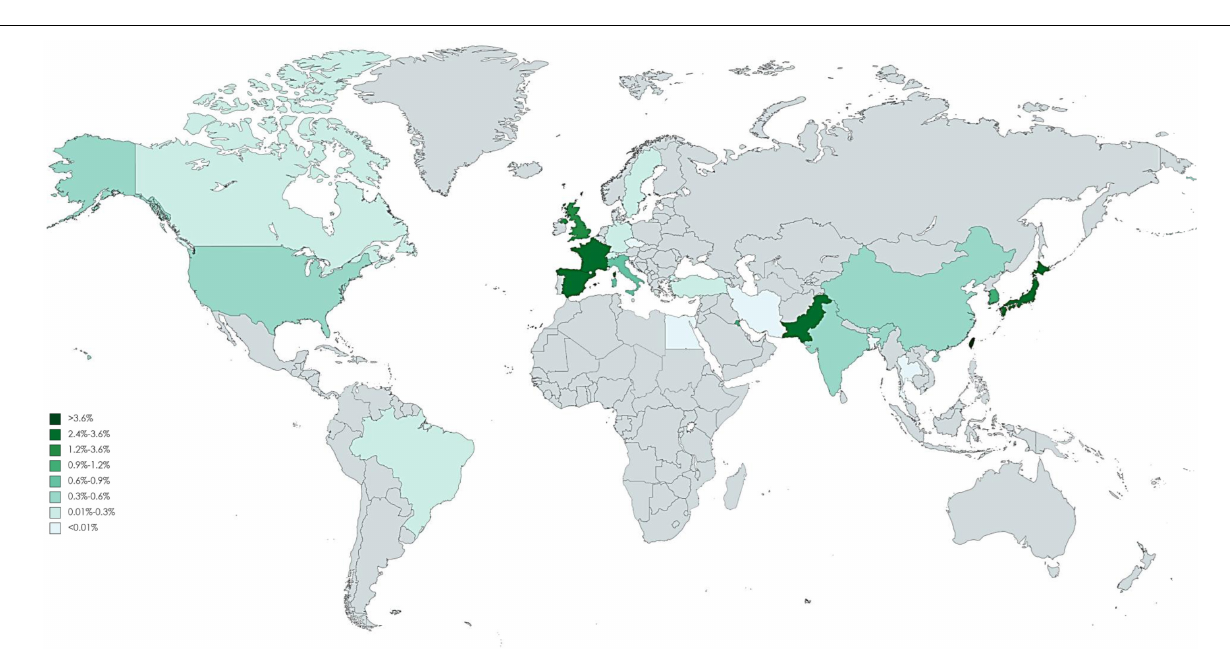
FIGURE 4 | Global incidence proportion of angiography-related contrast induced nephropathy requiring